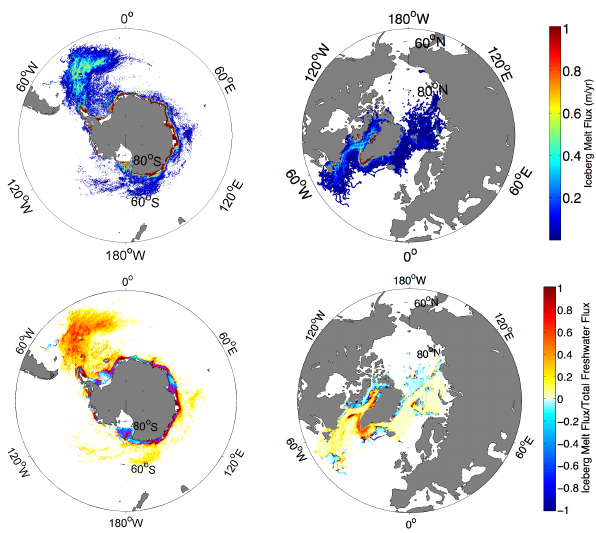
Figure 3. Iceberg total freshwater flux (year 26–30 average): total flux (myear − 1 ) – upper panels; fractions ( − 1 < 0 < 1) of iceberg freshwater flux to total freshwater input – lower panels.